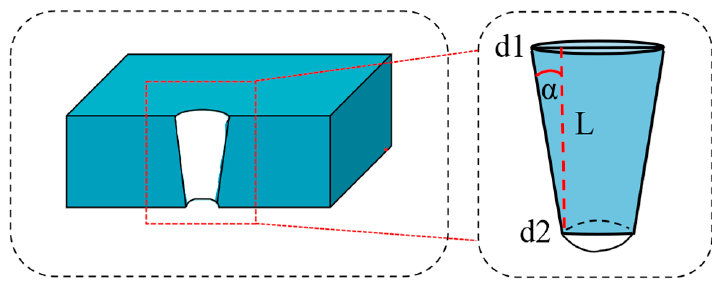
Figure 3. Schematic diagram of annular drilling. Figure 4. Schematic diagram of taper calculation.